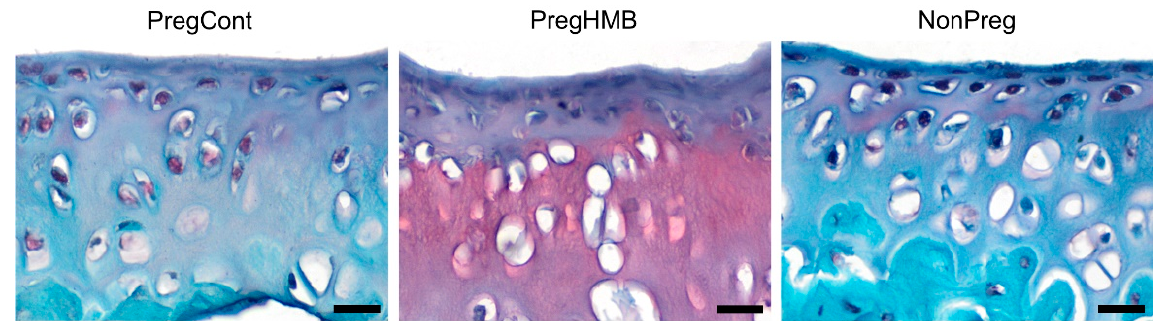
Figure 2. Representative images of Safranine O-stained sections of articular cartilage from femora of pregnant (control and supplemented with β -Hydroxy β -methylbutyrate (HMB)) and non-pregnant female spiny mice. PregCont—control pregnant females (not receiving HMB); PregHMB—pregnant HMB females (receiving HMB at a dose of 0.02 g/kg b.w. during the middle trimester of pregnancy); NonPreg—non-pregnant females. Scale bars represent 50 µm.